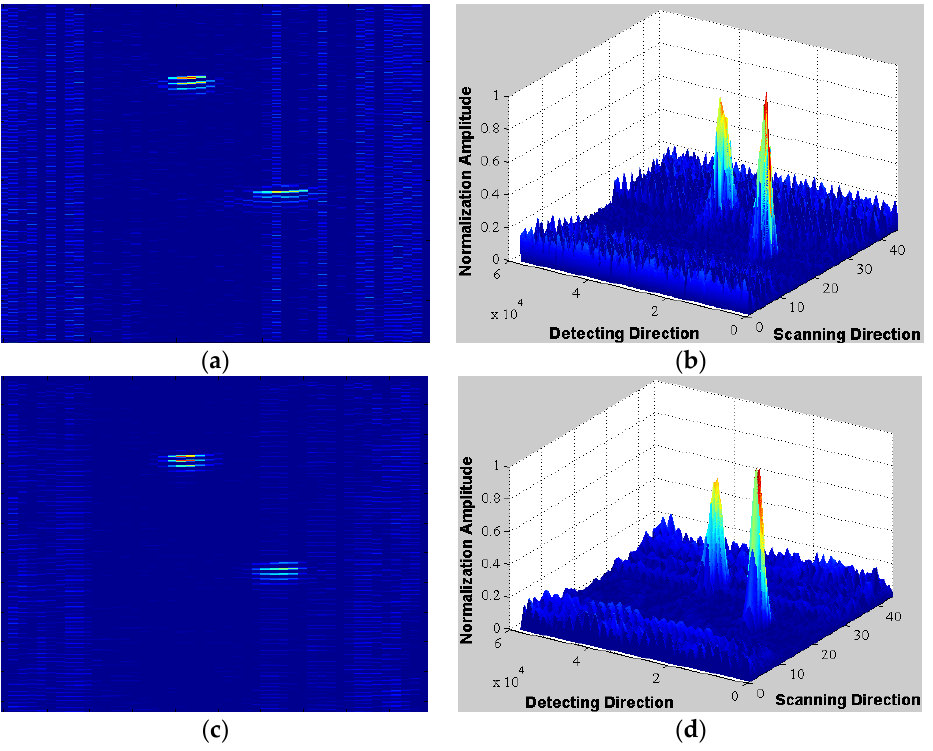
Figure 9. Reconstructed images ( a ) B-san reconstructed image; ( b ) 3-dimensional view of diagram (a); ( c ) SAFT reconstructed image; ( d ) 3 dimensional view of diagram (c).